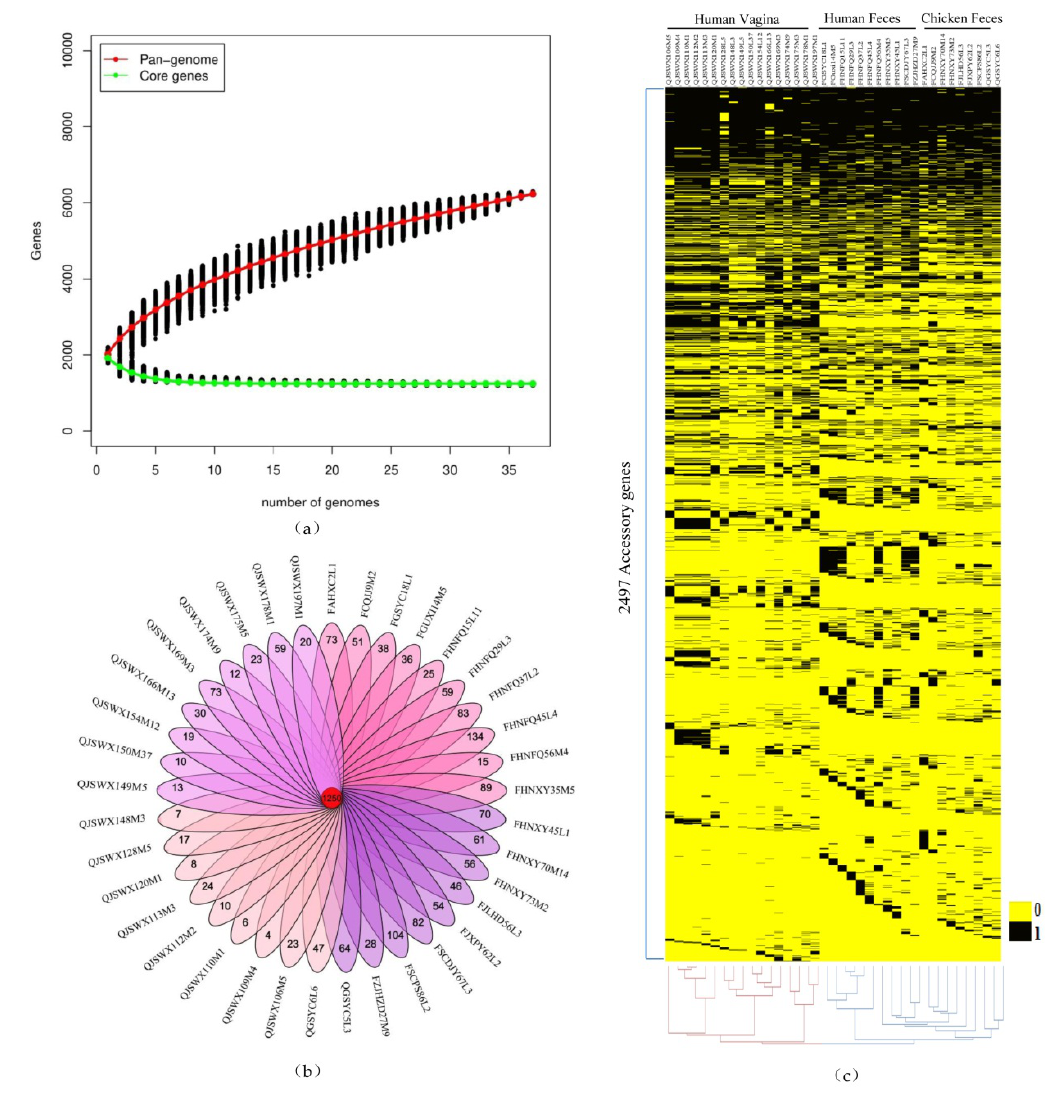
Figure 3. Pan-genome and core genome of L. crispatus. ( a ) The number of new genes accumulated in the L. crispatus pan-genome was plotted against the number of new genomes added and the number of accumulated genes attributed to the core genome relative to the number of added genomes. ( b ) Venn diagram representing the core and specific genes of 37 L. crispatus strains obtained by MCL clustering. The number in the middle red circle represents the number of core genes of the 37 strains. The numbers on the petals indicate the specific genes of each strain. ( c ) A heatmap representation of accessory genes against sequenced L. crispatus genomes. Each row represents an accessory gene. Each column represents a strain.